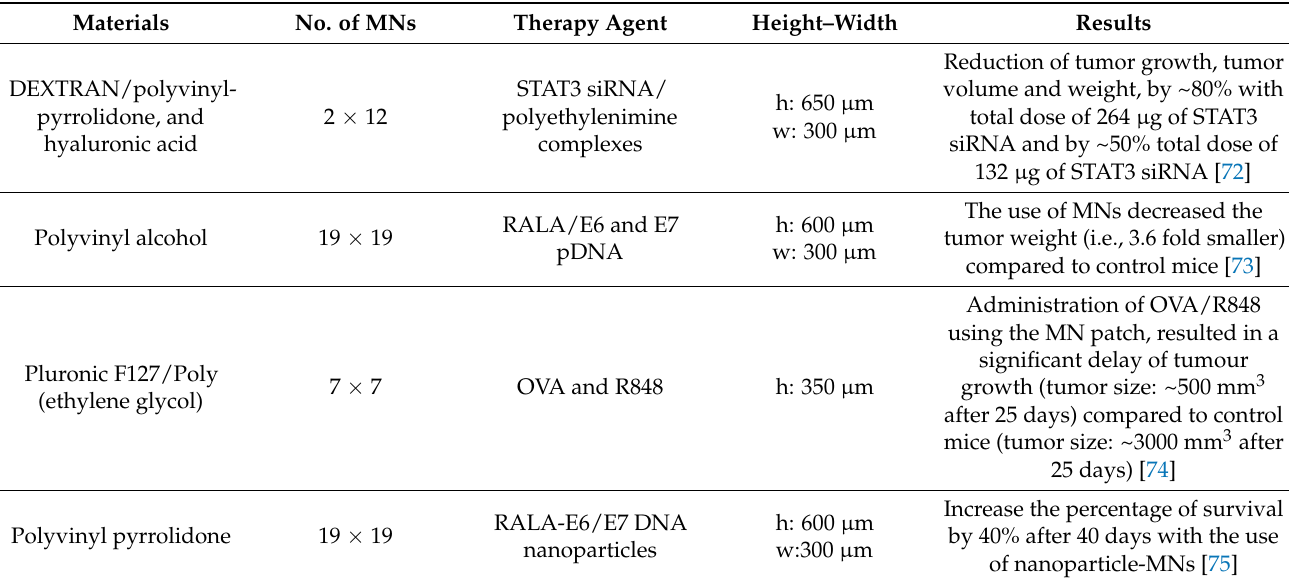
Table 1. Microneedles used in vivo as vaccines for cancer